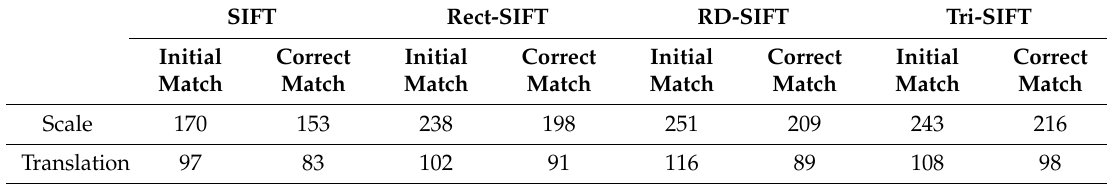
Table 1. Matching results of the four algorithms.